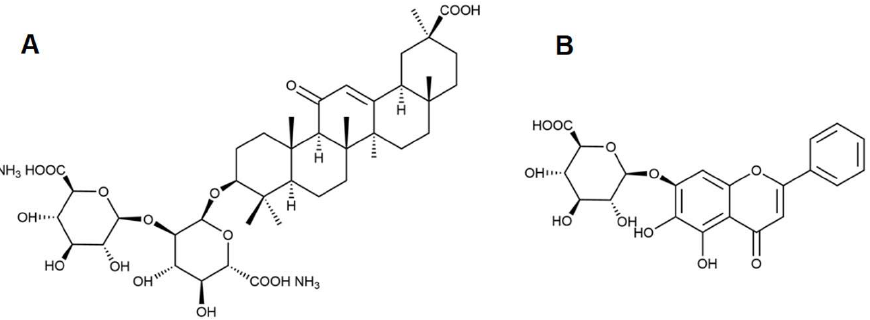
Figure 1. Chemical structures of diammonium glycyrrhizinate ( A ) and baicalin ( B ).